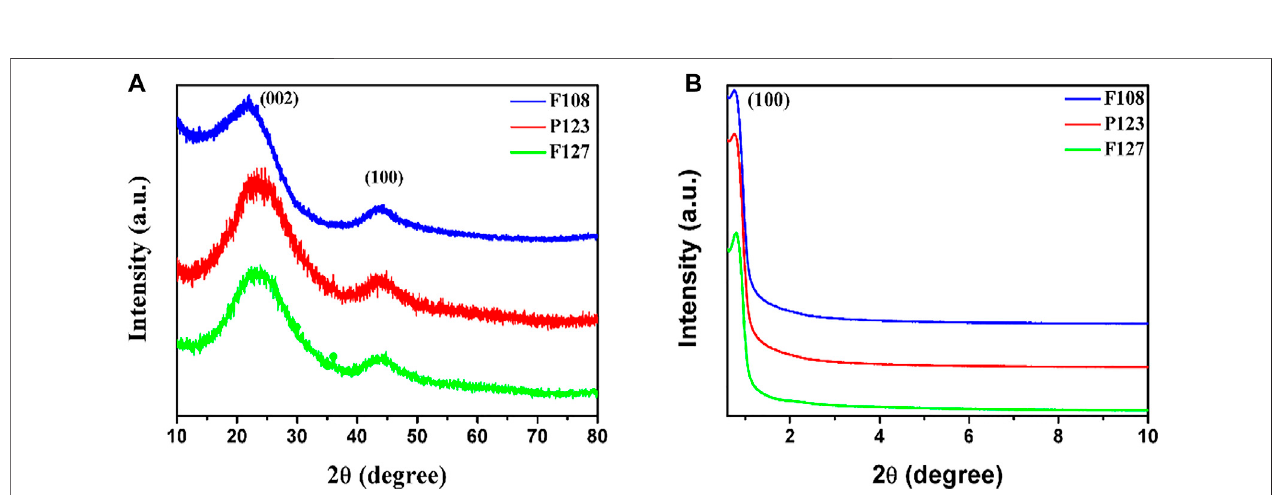
FIGURE 4 | (A) PXRD and (B) SAXRD patterns of the HPCs synthesized with different surfactants through the HISA method in the F127/ethanol micelle system.